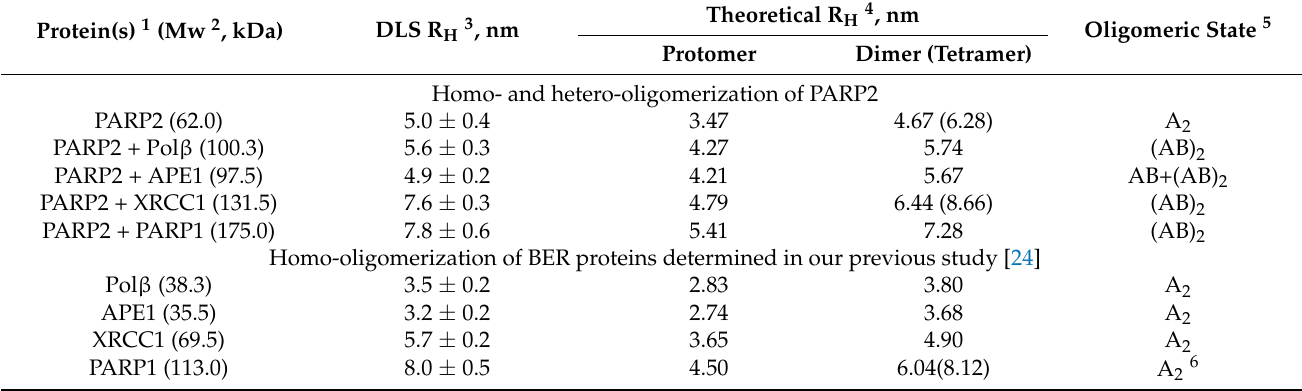
Table 3. Hydrodynamic radii and the most probable oligomeric states of PARP2 and its heterocomplexes with BER proteins. Protein(s) 1 (Mw 2 ,